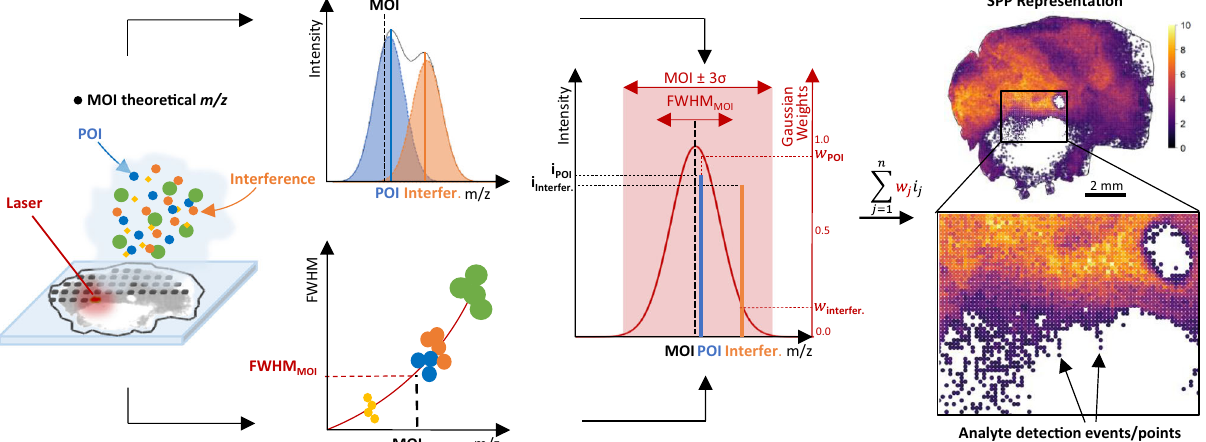
Fig. 1 | Data-dependent metabolite-of-interest (MOI)-centric Gaussian- weighting of ion intensities and transformation into a spatial point pattern (SPP) representation of the MOI. Full-width-at-half-maximum (FWHM) values are computed for all peaks of a randomly chosen full-pro fi le mass spectrum (Supple- mentaryFig.2a,b)andcurve- fi ttedtodescribeFWHMasafunctionof m/z .Forany MOI m/z (dashedblackline),aGaussianenvelopeiscomputedwhose σ G isinferred